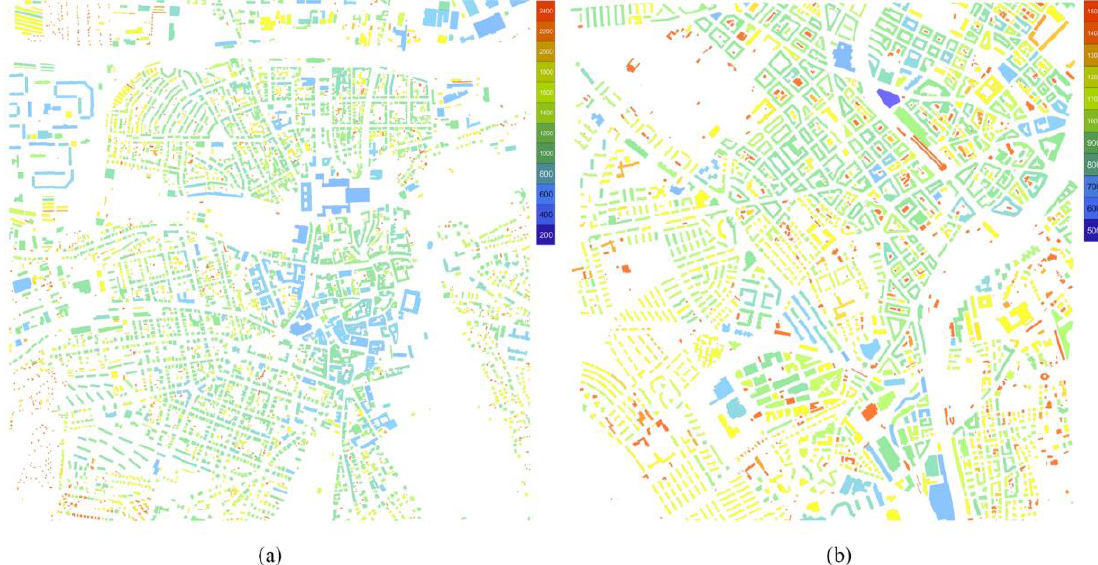
Figure 13. Heating energy use intensity (kW/m 2 /day) for Zurich (left) and Weimar (right).